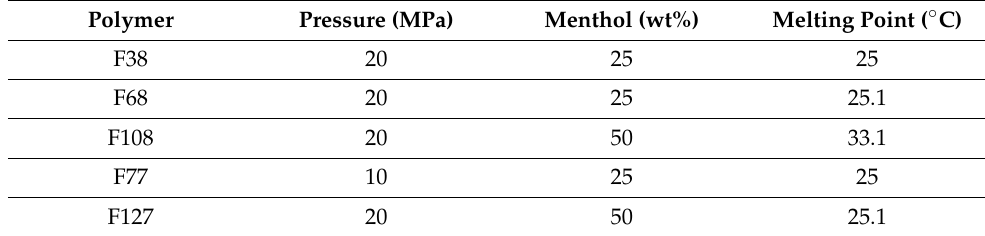
Figure 5. Melting point depression ( ∆ T) in Pluronics at 20 MPa in scCO 2 as a function of menthol content. Table 4. Lowest T m of Pluronics in scCO 2